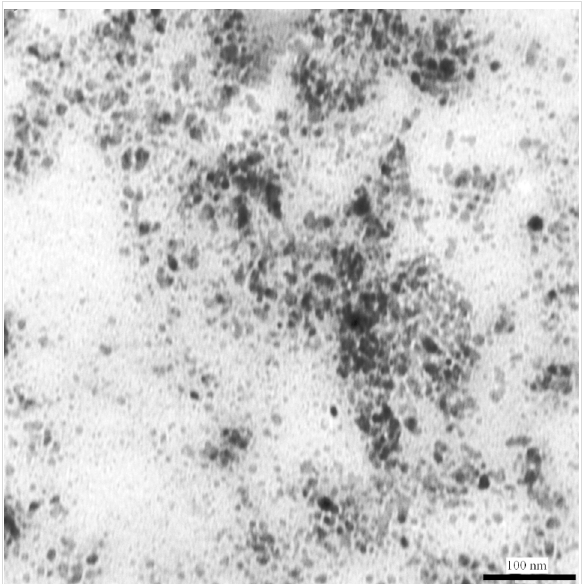
Figure 9: Typical TEM image of the CdSe quantum dots, synthesized by the reaction of 2.0 × 10 − 3 mol dm − 3 Cd(AcO) 2 with 1.0 × 10 − 3 mol dm − 3 Na 2 SeSO 3 , in the presence of 9.2% PVA, at 27 °C. TEM image was taken 6 months after the synthesis of the CdSe nanoparticles.